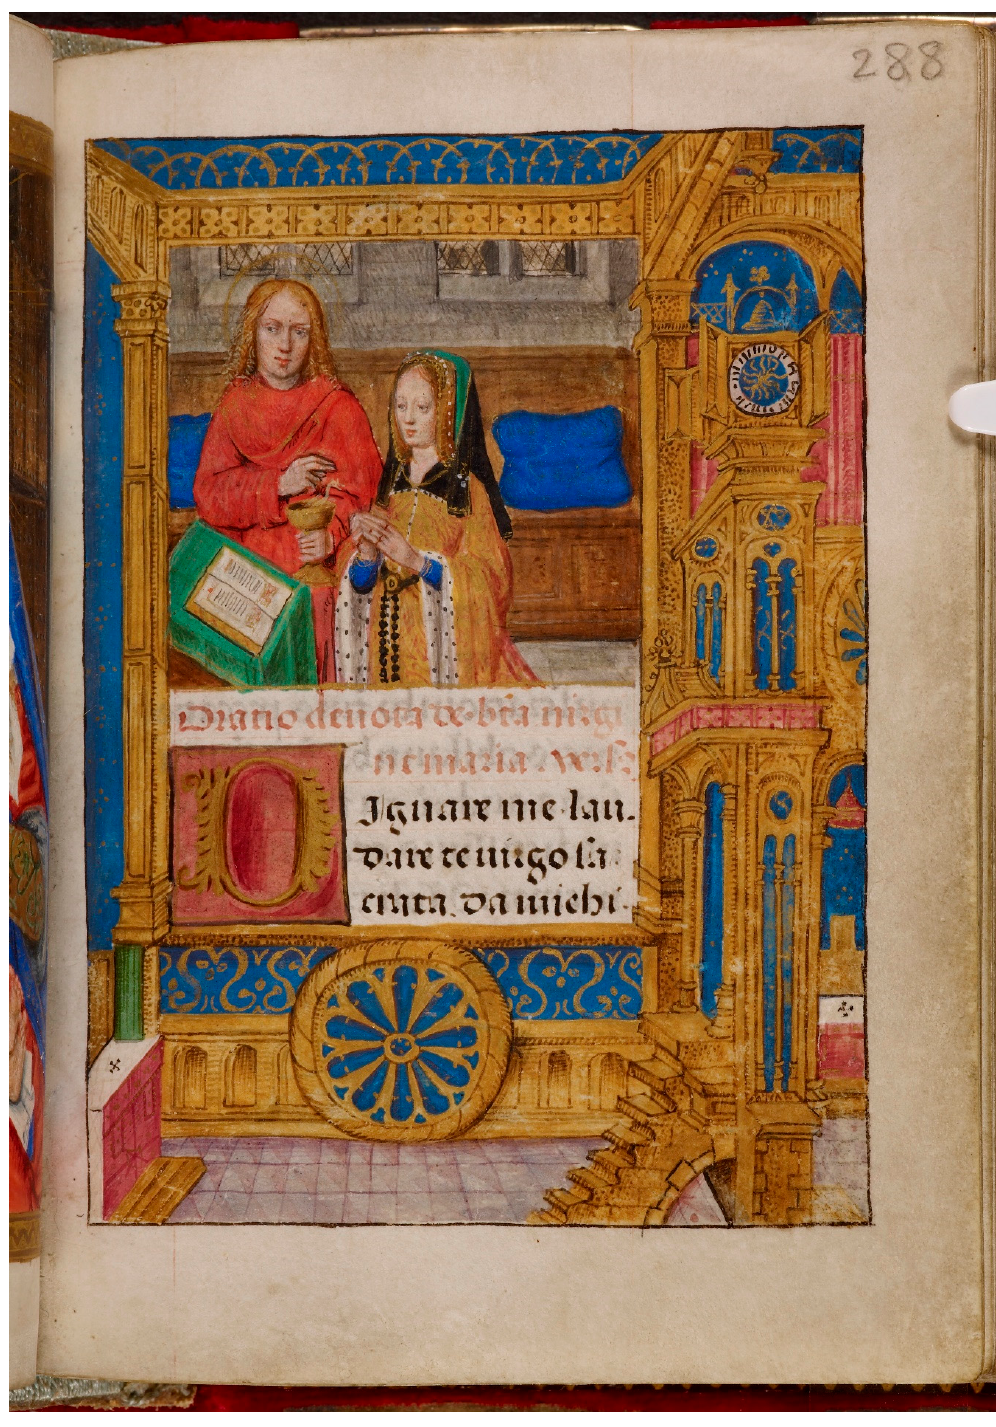
Figure 3. London, British Library, Add. MS 18852, fol. 288r, Juana at prayer with St John the Evangelist. The artist positioned Juana kneeling on the righthand page in the presence of the Virgin Mary (BL Add. MS 18852, fol. 287v–288r, figs. 2 and 3), a frequent response to acquiring a new book (Sponsler 1997, p. 104). The miniature Juana directs her gaze at the Virgin, bride and mother, no doubt signifying that, as a young bride, soon to be mother of the Archduke, she sought to place herself